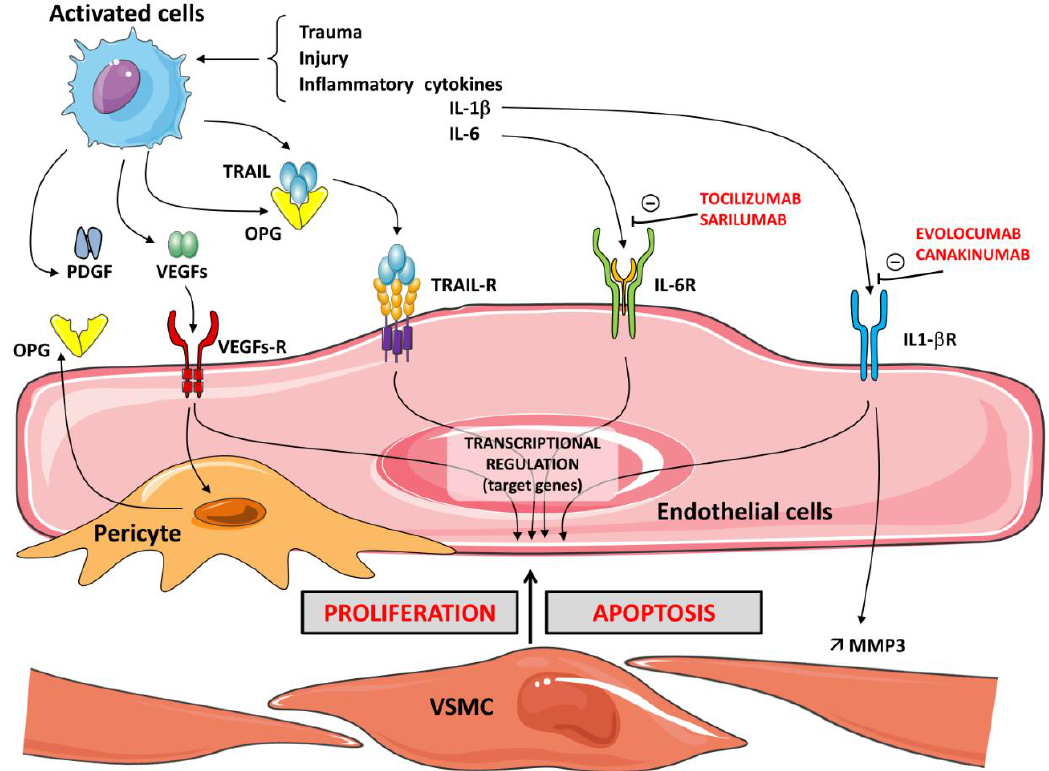
Figure 2. Schema illustrating the relationship between the OPG/TRAIL/TRAIL-R system, pericytes, growth factors, and the cytokines IL-1 and IL-6 on the balance between proliferation and apoptosis of vascular smooth muscle cells (VSMC). In the presence of inflammatory cytokines IL-1 β or IL-6 and trauma or injury, activated cells express OPG. Activation of cytokine receptors IL-1R and IL-6R induces the recruitment of monocytes and neutrophils. The growth factor system, which includes vascular endothelial growth factors (VEGFs) and PDGF, influences the proliferation (angiogenesis) and OPG expression in vascular cells. Associated with the microvasculature, pericytes secrete elevated amounts of OPG. OPG also acts as a receptor for TRAIL. TRAIL binds to its receptors, TRAIL-Rs. The cellular actions of TRAIL are tightly regulated in a balance between the apoptosis and proliferation of vascular cells. TRAIL and RANKL increase matrix metalloproteinase (MMP) activity, leading to degradation of the extracellular matrix. The cellular actions promoted by IL-1 β induce MMP-3 production. MMP-3 is constitutively expressed in EC and VSMC. The human monoclonal antibodies canakinumab and evolocumab, which target IL-1 β , have anti-inflammatory effects. Sarilumab and tocilizumab are human monoclonal antibodies against the IL-6 receptor- α. Intracellular signaling of IL-6 in response to receptor activation is complex—anti-inflammatory protective but pro-inflammatory for the immune response.